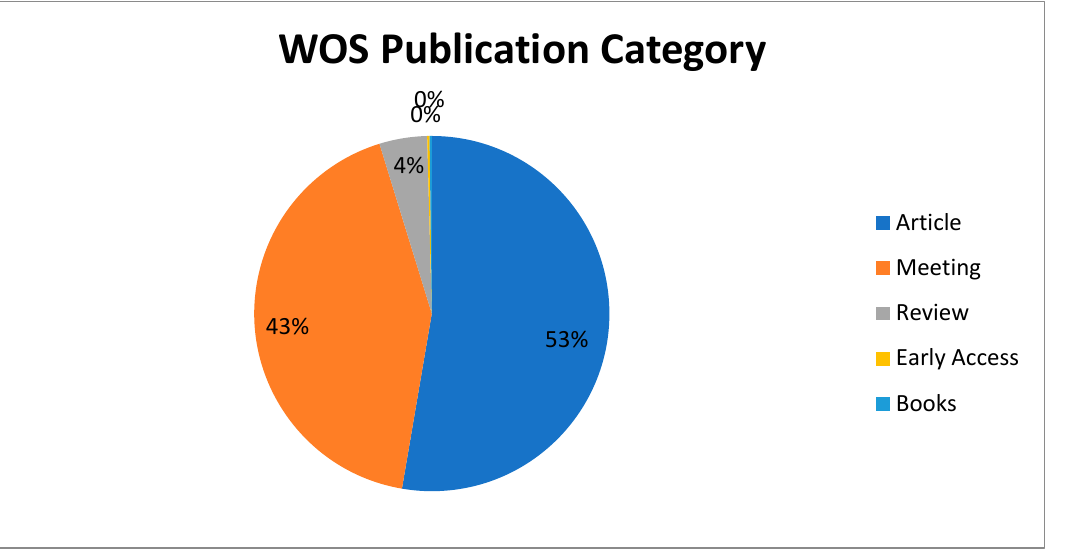
Figure 6. WOS DB publication category in the field of BMS EV.